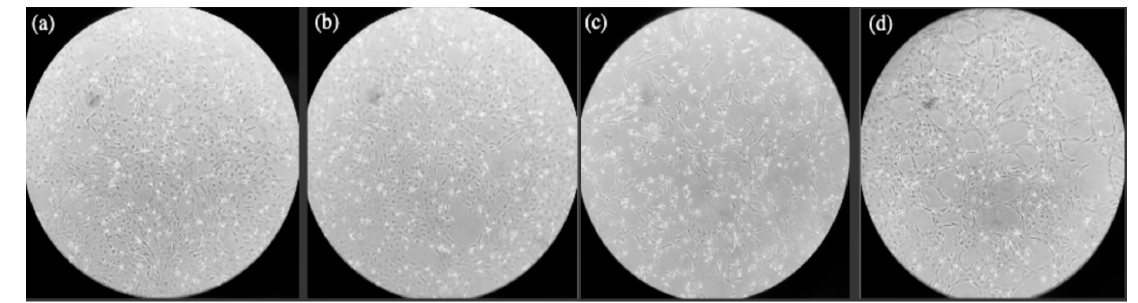
Figure 2. Morphological features of Bos Taurus cumulus cells. ( a ) Control group after 24-hr treatment; ( b ) Vehicle group after 24-hr treatment; ( c ) BPA group after 24-hr treatment; ( d ) BPS group after 24-hr treatment. Images obtained by inverted phase contrast microscope at 10 × objective.